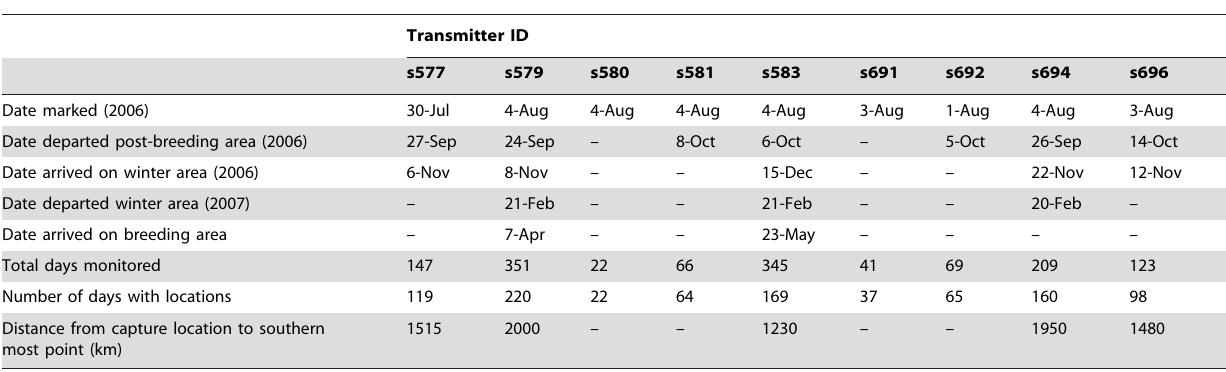
Table does not include s584, for which messages were not received . 7 d after release. doi:10.1371/journal.pone.0005729.t002 PLoS ONE |